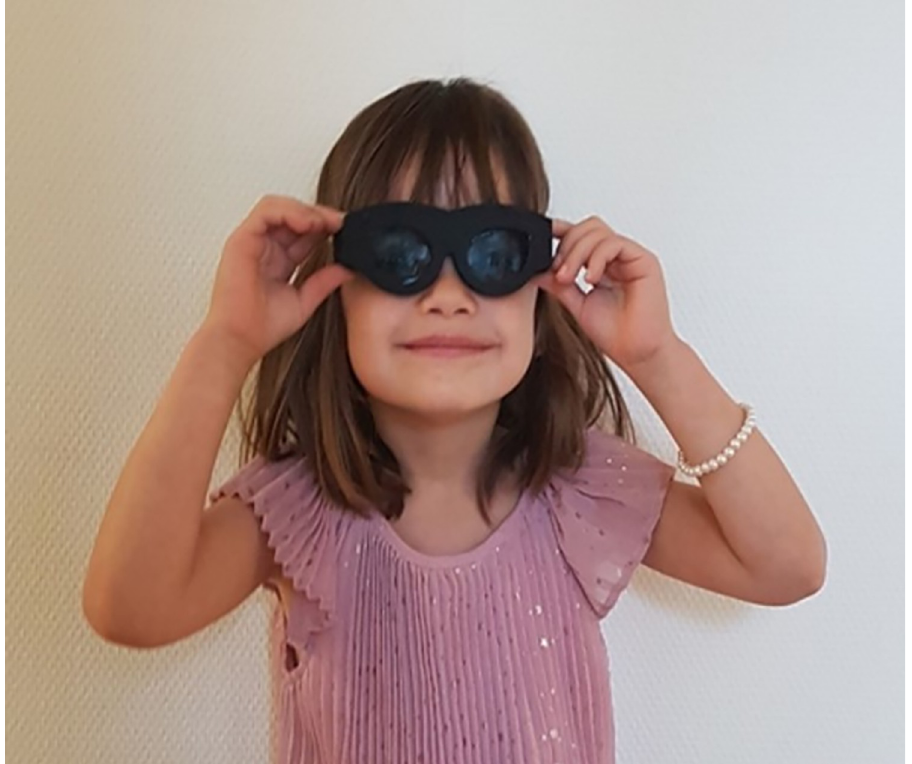
Fig 6. Happy child wearing the assembled LCD shutter